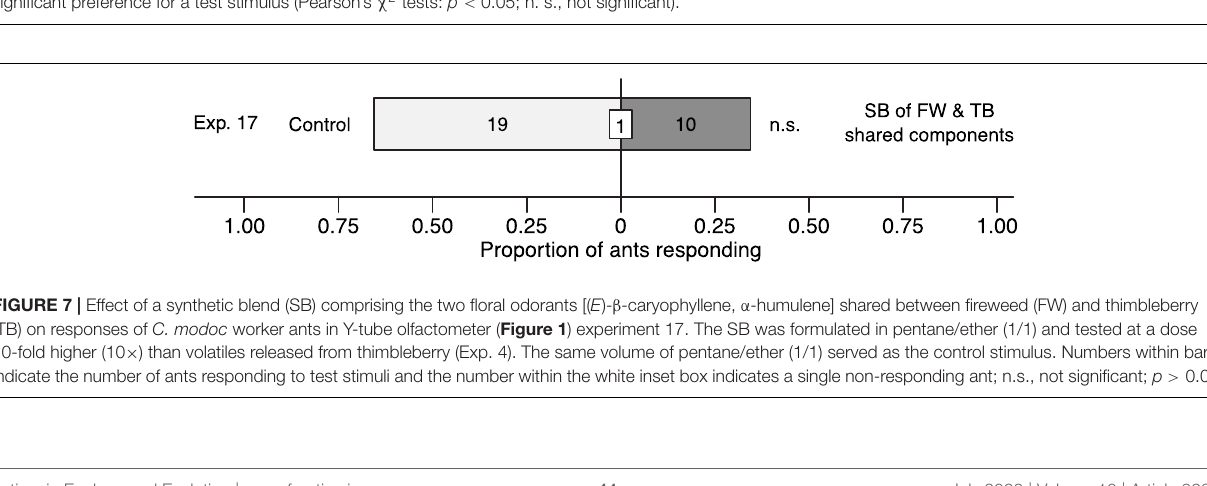
Frontiers in Ecology and Evolution |